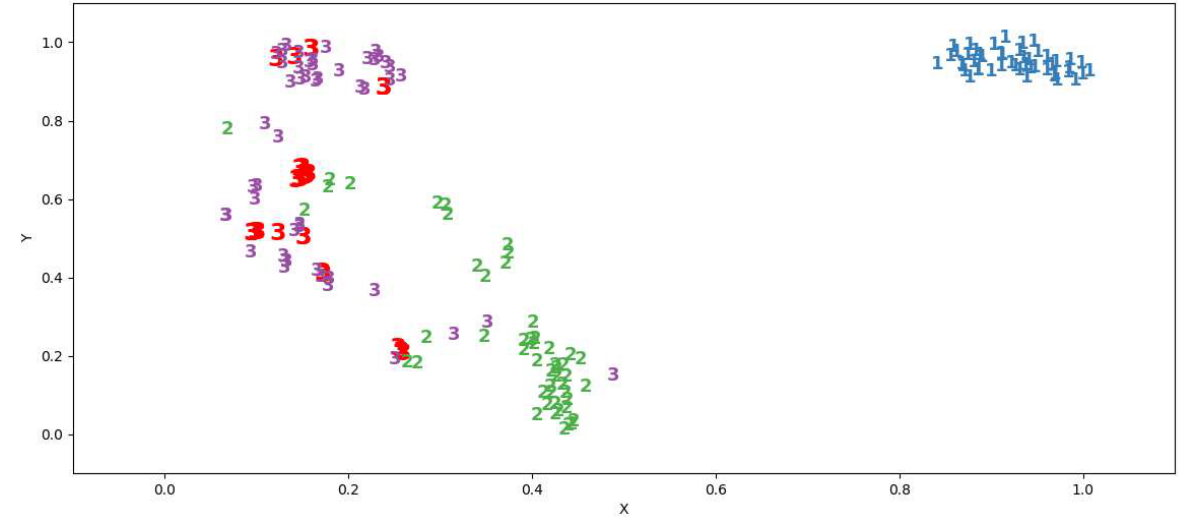
Figure 10. Successful adversarial attacks on the EnAE classifier (highlighted in red).